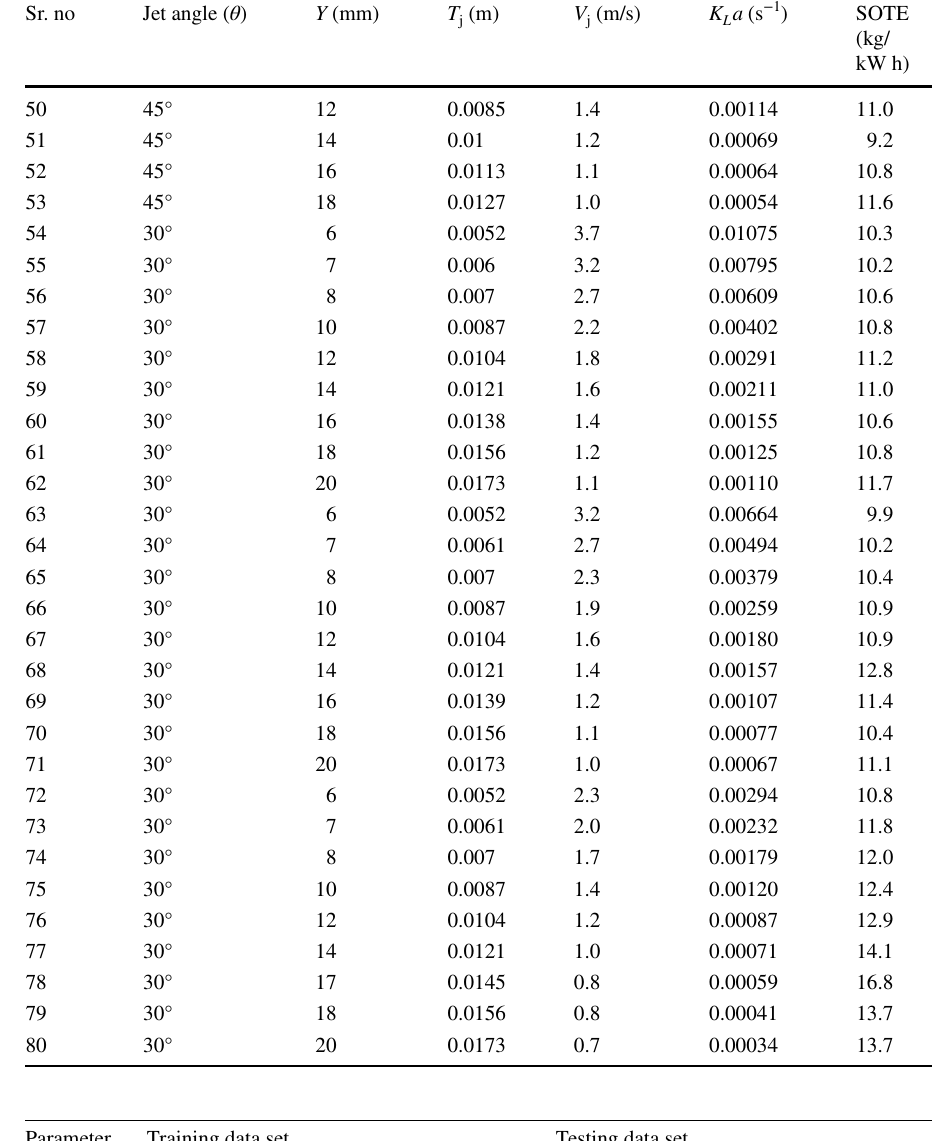
Table 2 Details of the